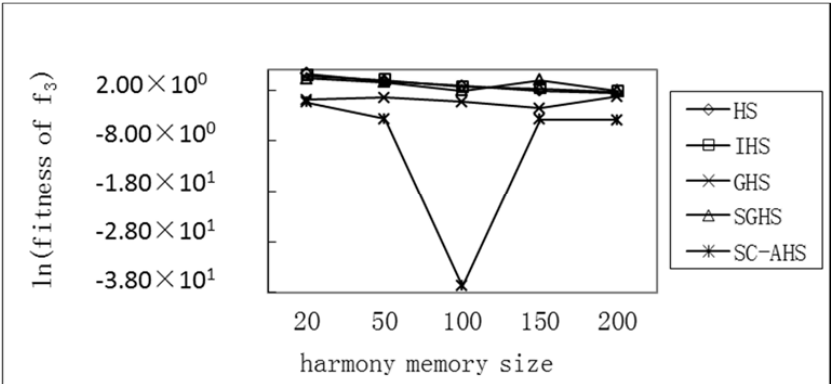
Figure 8. Comparison of the average optimum with different harmony memory sizes of the Rastrigrin function.